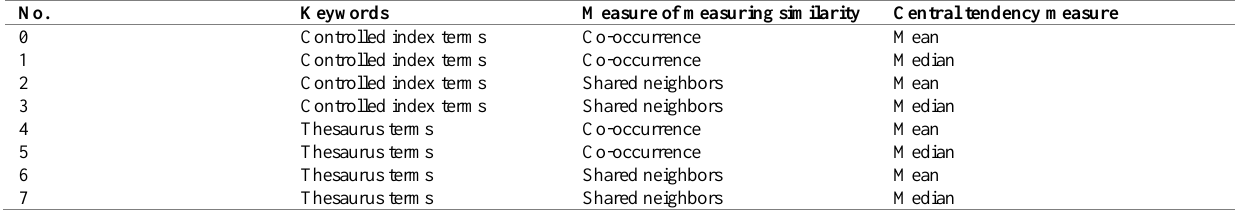
Table 4. Different configurations of the assessment.